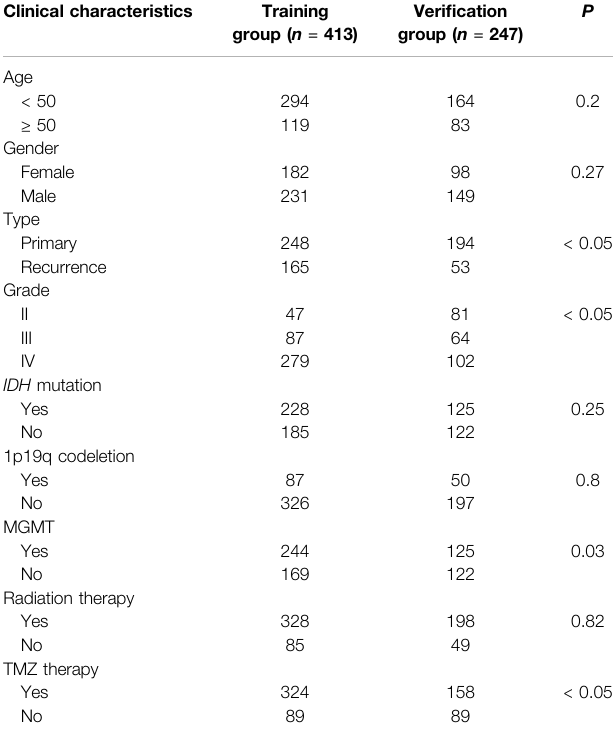
TABLE 1 | Clinical